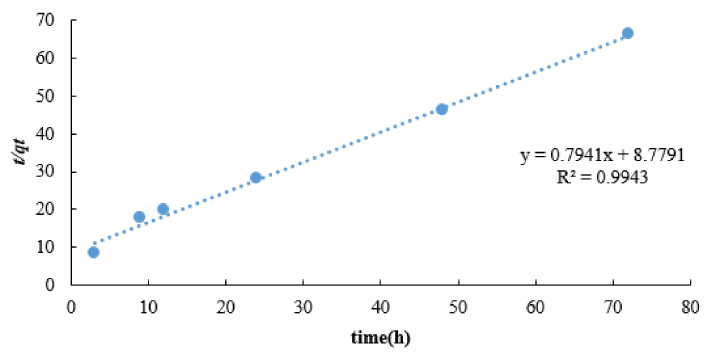
Figure 15. Pseudo-first-order linear kinetic model of Cr(VI) adsorption on the SDS-chitosan beads.